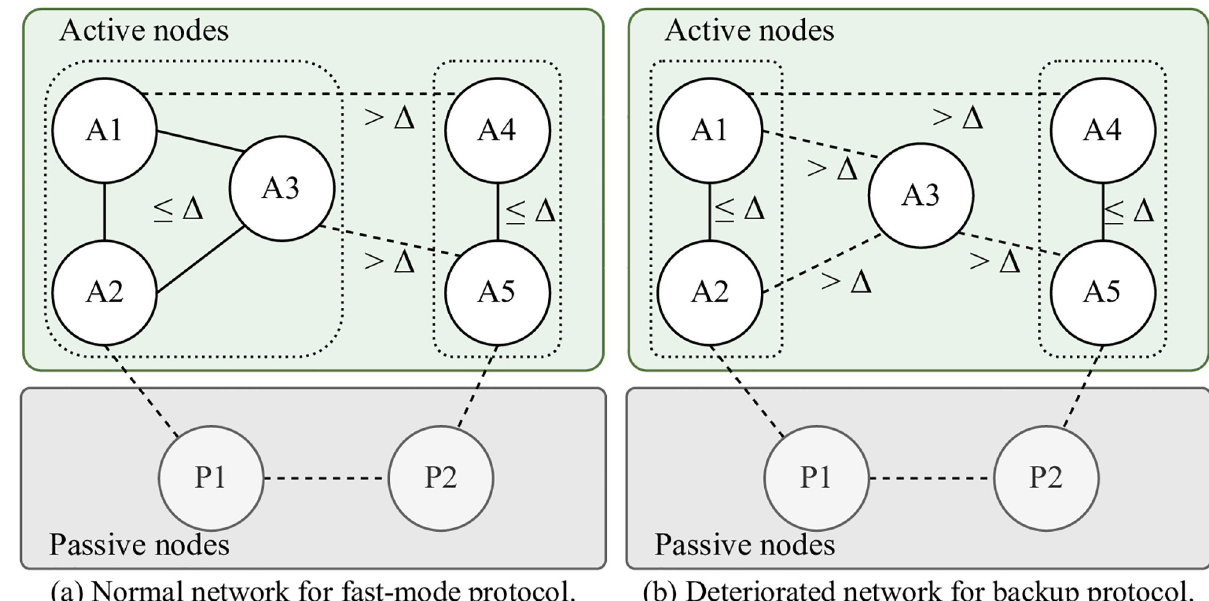
Fig 1. Network conditions for fast-mode and backup